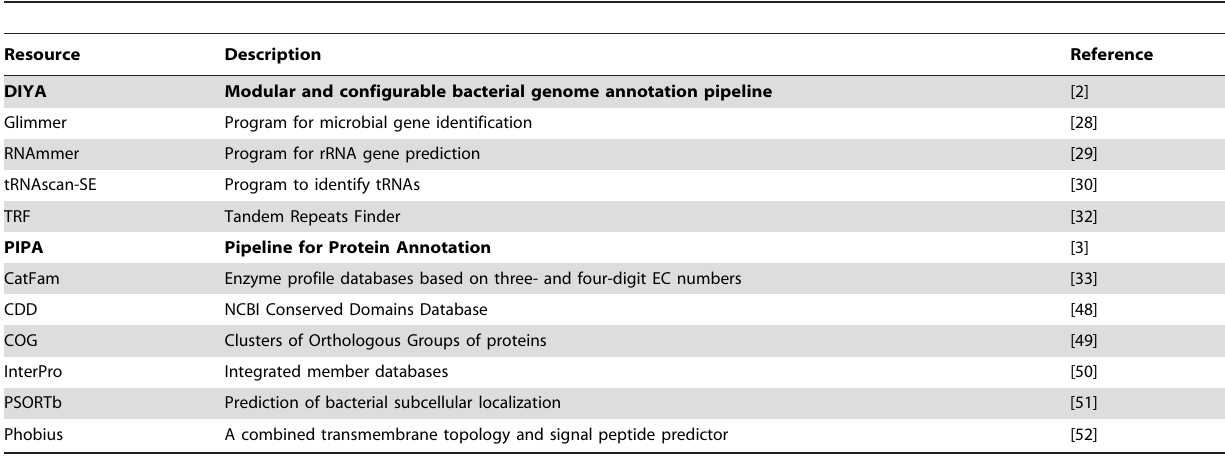
Table 1. List of genome annotation tools incorporated in DIYA and protein annotation tools integrated in PIPA.